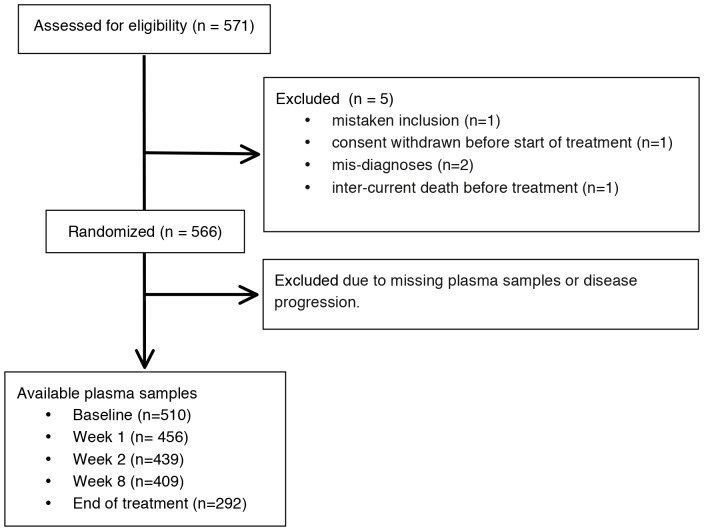
Consort diagram indicating sample sizes at each stage during the study.